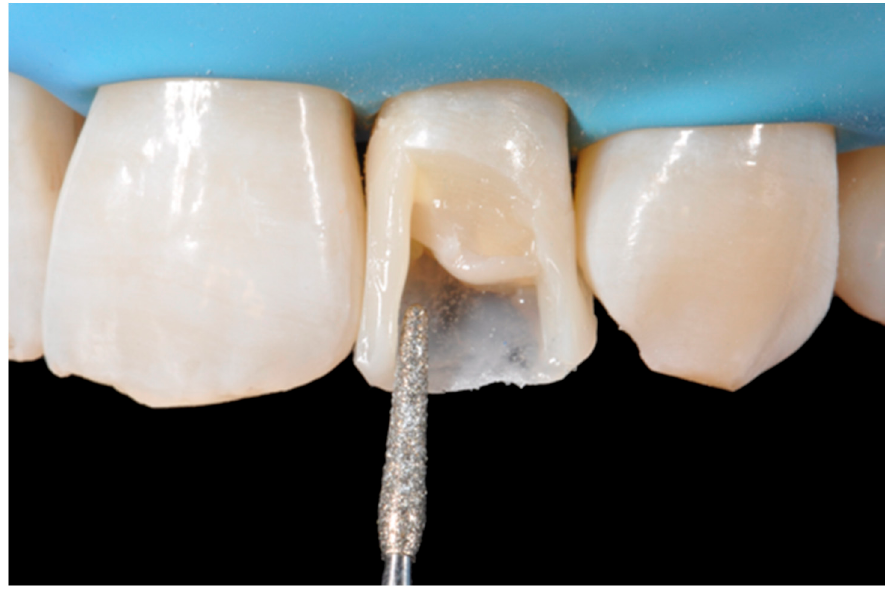
Figure 24. Frame is corrected with the help of diamond burs. Reprinted from Restauri diretti nei settori anteriori, G. Paolone, S. Scolavino, © 2021, with permission from Quintessence Publishing Italy.